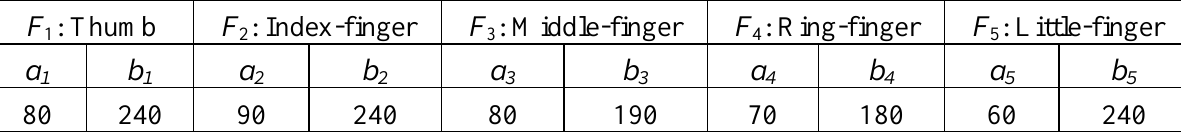
Table 2. Values a and b -parameterized bending degree function.